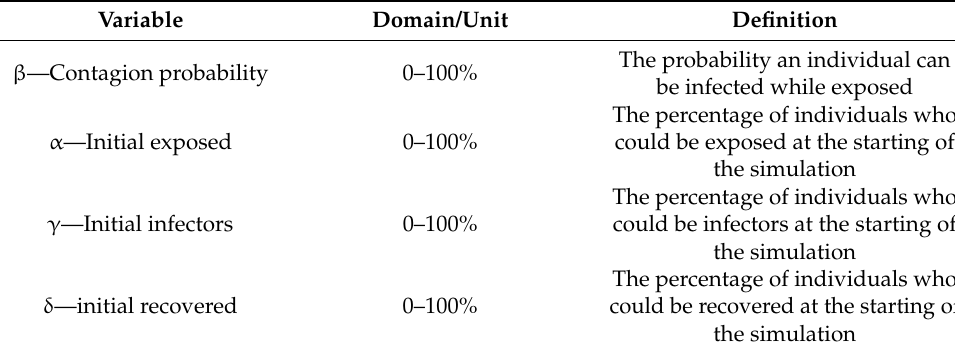
Table 4. General model variables.